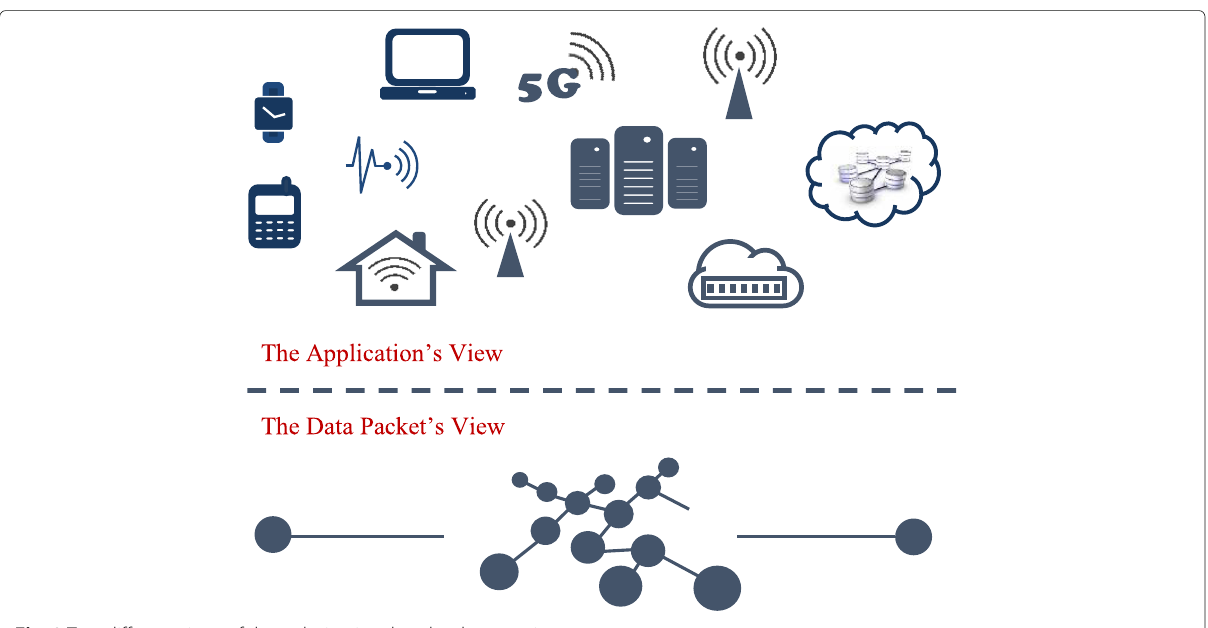
Fig. 2 Two different views of data relaying in edge cloud